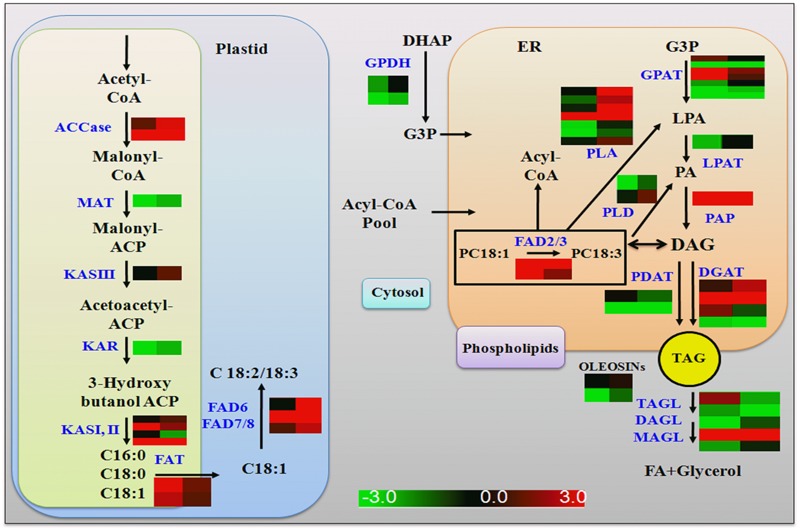
Summary of genes regulated by GmLEC2a in de novo TAG biosynthesis pathway. ACCase, Acetyl-CoA carboxylase; MAT, malonyl-CoA-ACP transacylase; KAS, 3-oxoacyl ACP synthase; KAR, 3-oxoacyl ACP reductase; FATA/B, fatty acyl-ACP thioesterase A/B; FAD2/6, D12(ω6)-Desaturase; FAD3/7/8, D15 (ω3)-Desaturase; GPAT, glycerol-3-phosphate acyltransferase; LPAT, lysophosphatidyl acyltransferase; PP, phosphatidate phosphatase DGAT, diacylglycerol O-acyltransferase; PDAT, phospholipid: diacylglycerol acyltransferase; PLA1/2, phospholipase A1/2; PLD, phospholipase D. Right panel of heat map represents gene expression in GmLEC2a- transgenic roots; left panel represents expression in control (GUS) hairy toots.